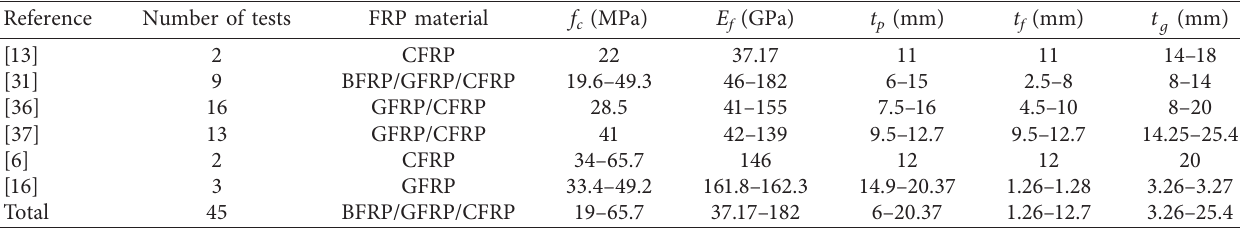
Table 4: Database under the adhesive failure mode.